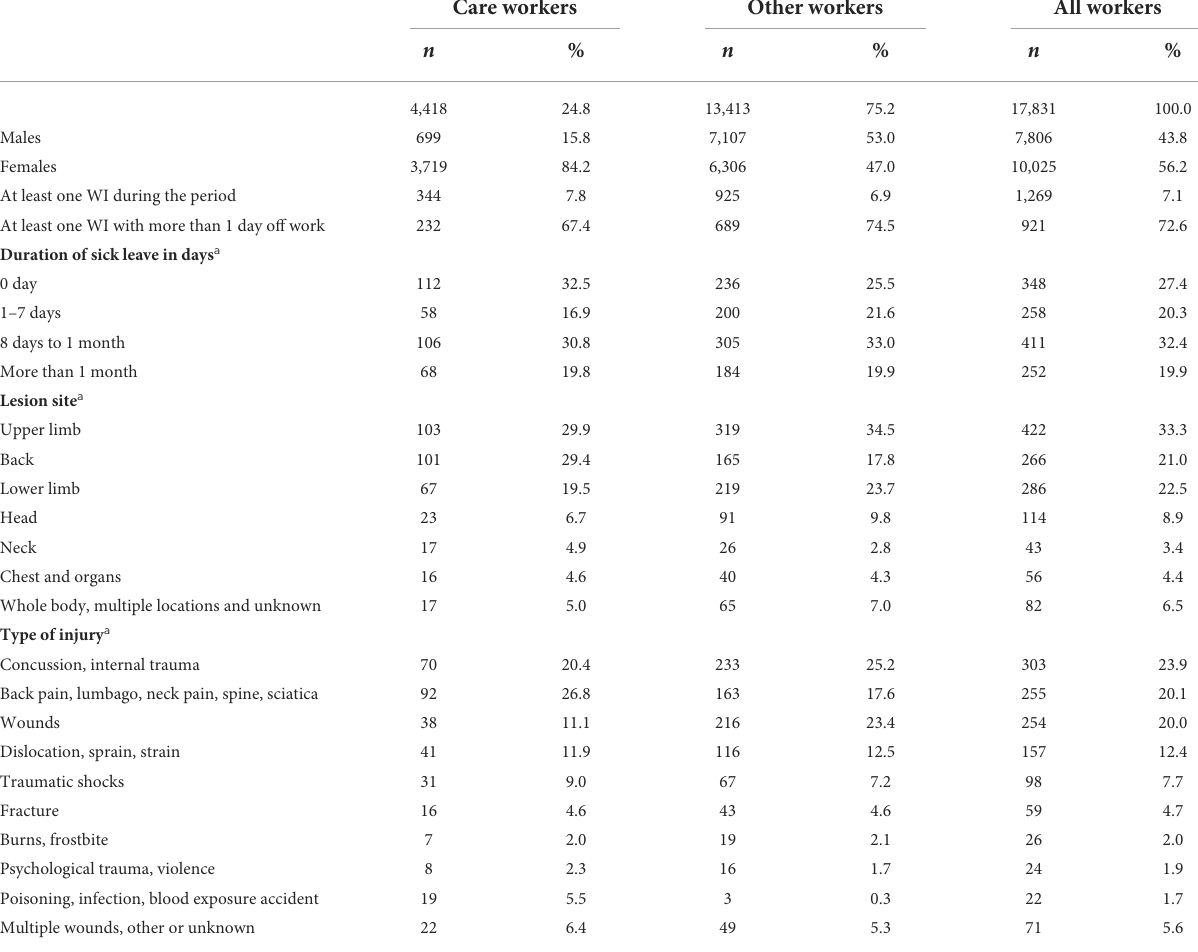
TABLE 2 Description of workplace injuries (WI) occurred in the follow up period for the entire study population and for care workers. Care workers Other workers All